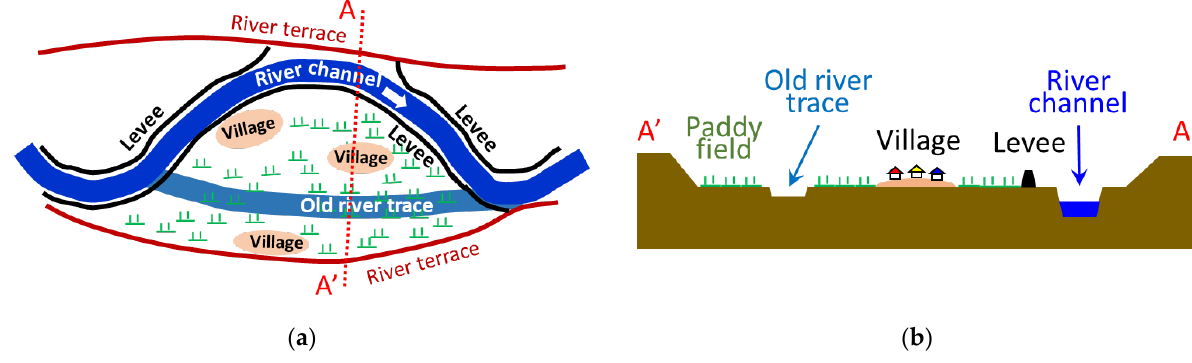
Figure 5. Schematic diagrams of upstream floodplain; ( a ) plan view and ( b ) cross section. Ishikawa [8] and Ito et al. [9] investigated the possibility of restoring the retarding effect of upstream floodplains against excess rain runoff and proposed the concept of an RWRB, which is shown in Figure 6. An overflow dike is installed near the upstream edge of a closed floodplain, the top of which is set at the design HWL of the levee so that a flood smaller than the channel design discharge does not flow into the floodplain. When the HWL is exceeded, excess water flows into the RWRB and spreads over the paddy fields as shown by white arrows with red lines. Since there is a freeboard of 1 to 1.5 m from the HWL to the crest of the levee, it will not be overtopped unless an extraordinary flood occurs. The levees on the downstream side of the floodplain are opened for the drainage of floodwater. In the flood rising phase, the river water runs up from the opening, but since the ground in the river upstream area is sloping, the range of run-up is small. The stored water also dissipates the energy of flow from the old river traces.